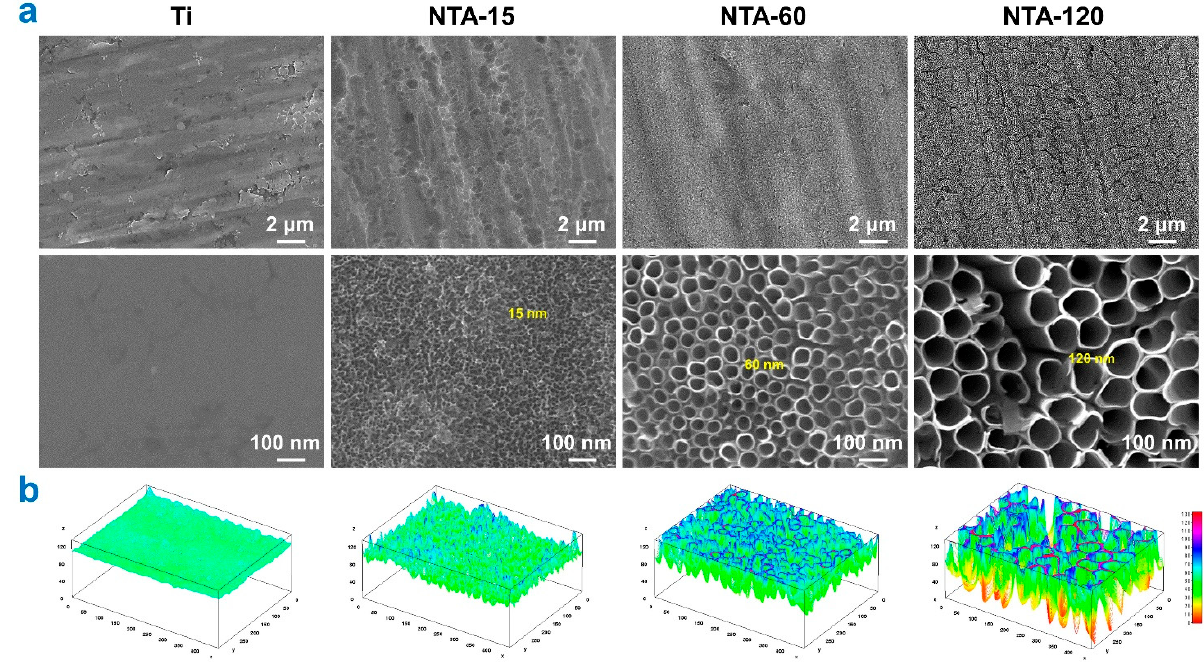
Figure 1. Surface topography of Ti and NTAs. ( a ) Representative SEM images of Ti and NTAs. ( b ) Surface 3D profiles of Ti and NTAs.